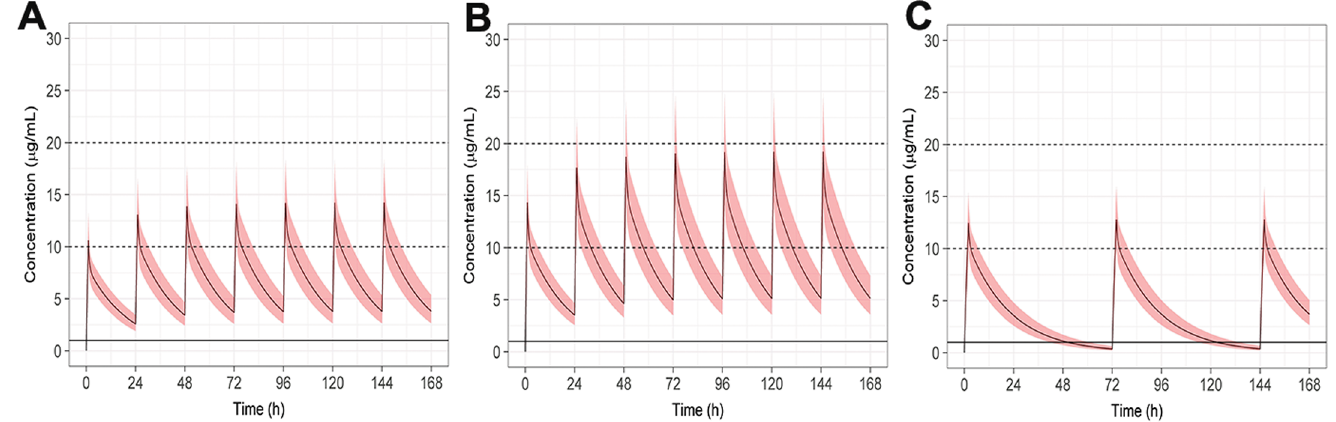
Fig 2. Plots of caspofungin concentration over time. A) 0.75mg/kg dosing daily for 7 days, B) 1mg/kg dosingdaily for 7 days, C) 1mg/kg every 72 hours for 7 days. Solid black line indicatesthe median,shaded ribbonshows the 90% CI. Dashedblack lines show the putative upper and lower C max targets.